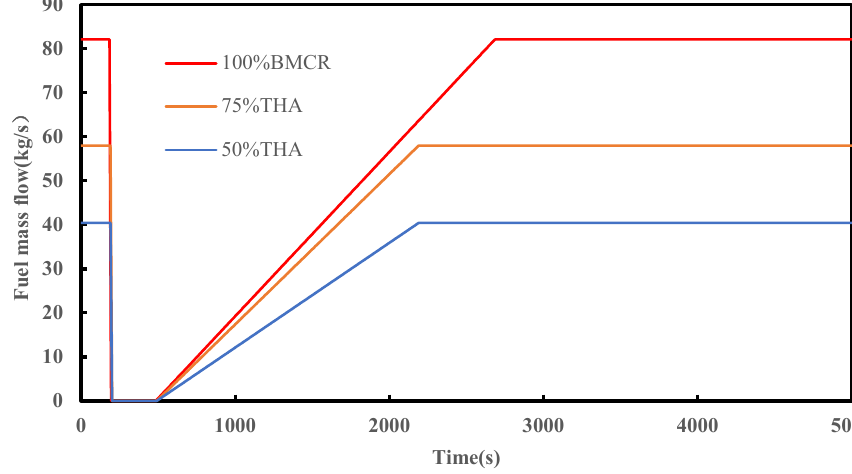
Figure 9. Response of fuel mass flow during MFT at different conditions.